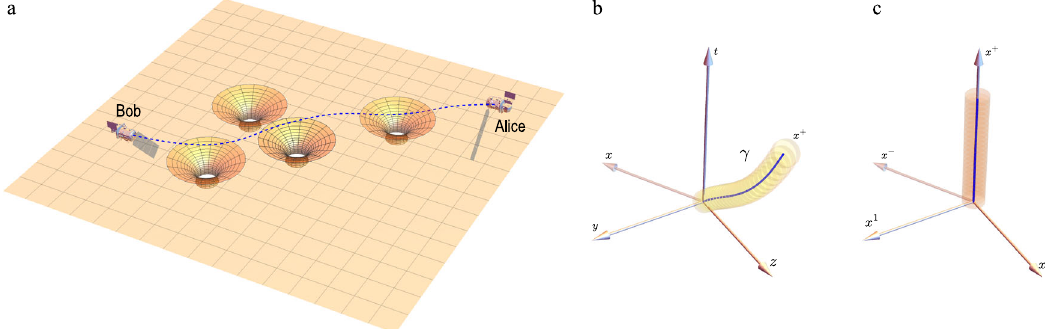
Fig. 1 Schematics of communication in a general curved spacetime geometry and proper chosen coordinates. a Two parties, namely Alice and Bob, communicate in a general curved spacetime geometry. Alice encodes her message in a sequence of information carriers and sends them to Bob. The information traverses through the spacetime over a geodesic γ . The physical traits of information are distorted by the curvature of the spacetime, causing errors to the fi eld wavepacket. b The shown null geodesic γ . Close to γ , at the local coordinates, the metric is approximately pseudo-Euclidean. c The associated Fermi coordinates, the null-geodesic-path is mapped to x +